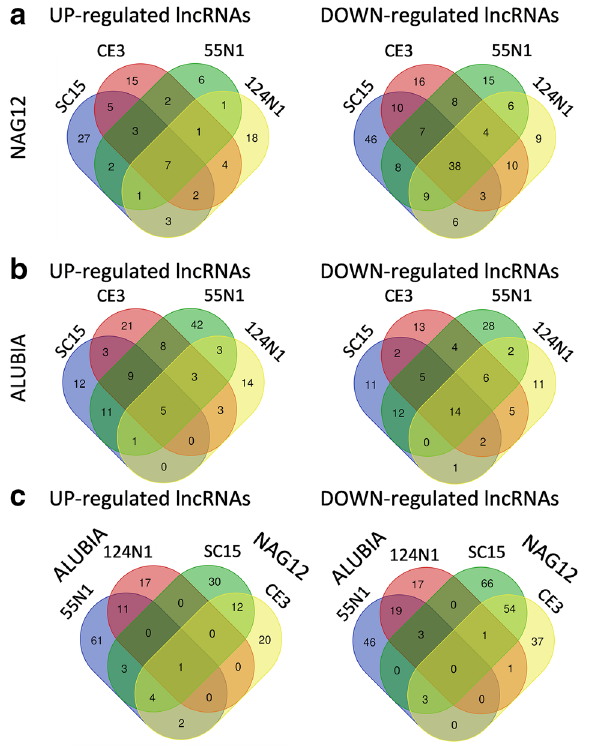
Figure 7. Identification of common and strain-specific DEGs classified as lncRNAs. Venn diagrams showing the number and overlap of up- and down-regulated lncRNAs in NAG12 ( a ), Alubia ( b ) in response to nod C-α (SC15 and CE3) or nod C-δ (55N1 and 124N1) R. etli strains or in the more efficient interactions in each accession ( c